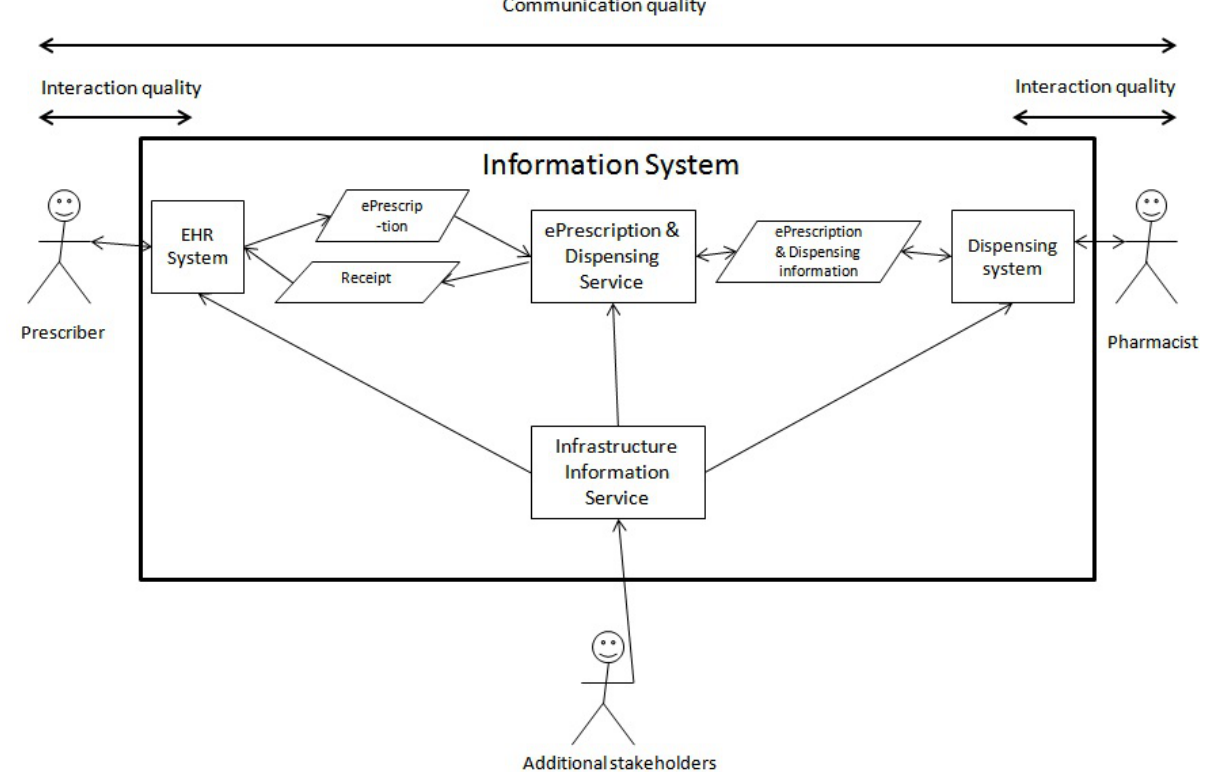
Figure 4. Overview of IS and stakeholders involved in ePrescribing